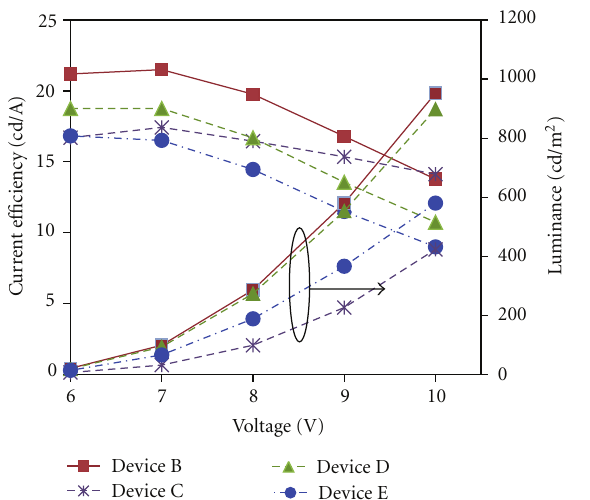
Figure 5: Current e ffi ciency-voltage-luminance characteristics of the devices (C, D, E) compared with those of device B.